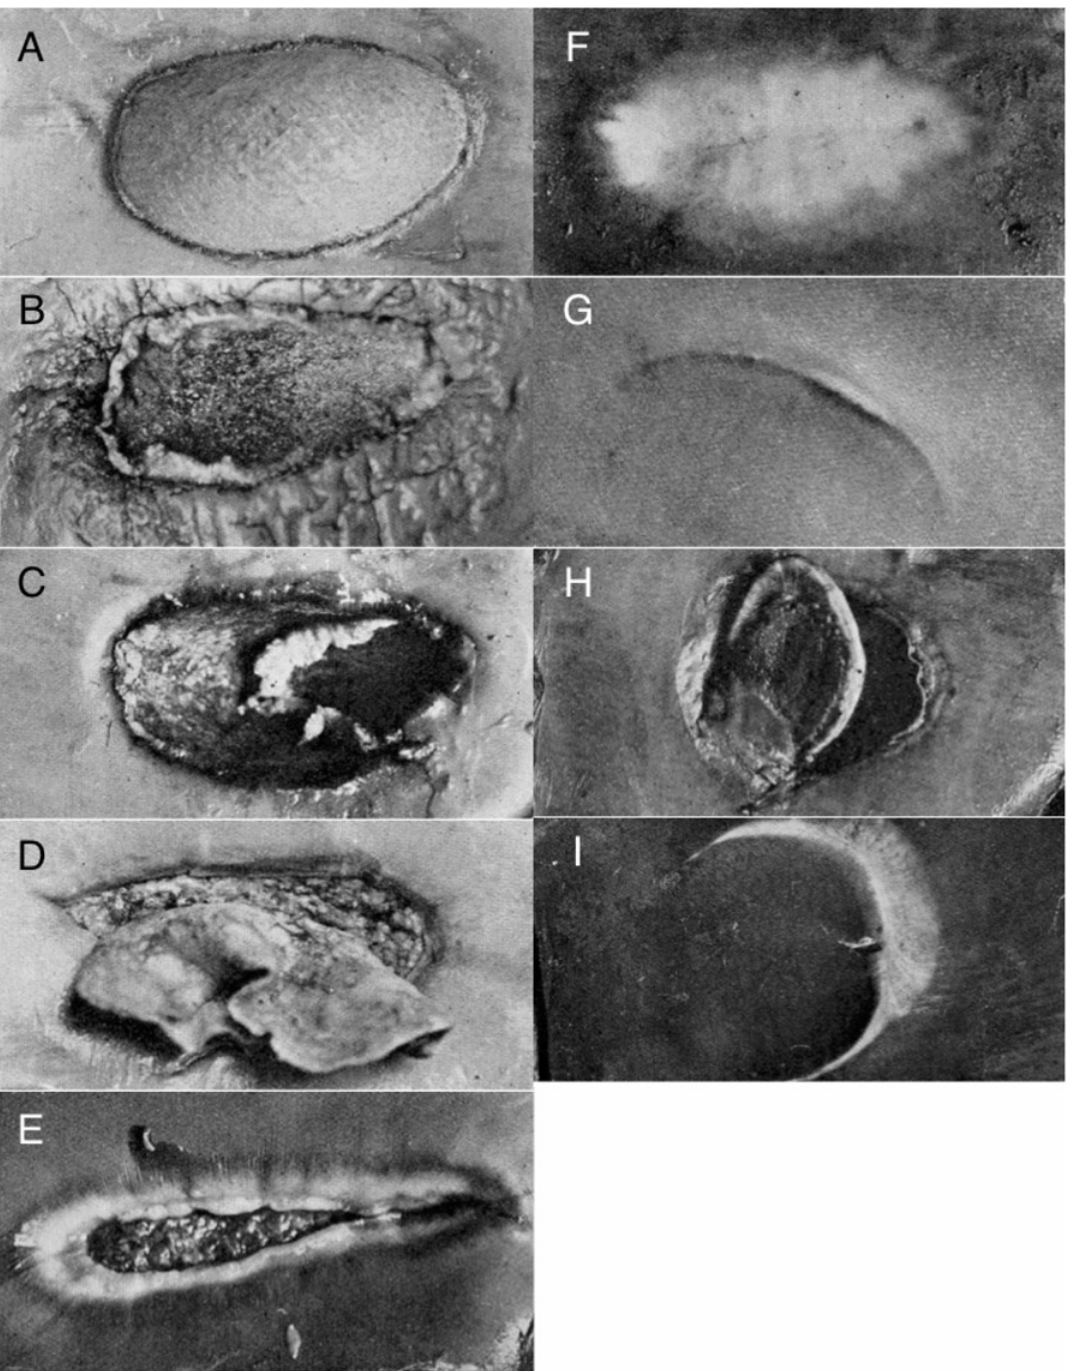
Fig 3. Categorisation of bite wounds on large whales at Donkergat whaling station (from [6]): A pink/fresh oval, B — E healing ovals, F healed oval, G attempted half-scoop, H open half-scoop and I healed